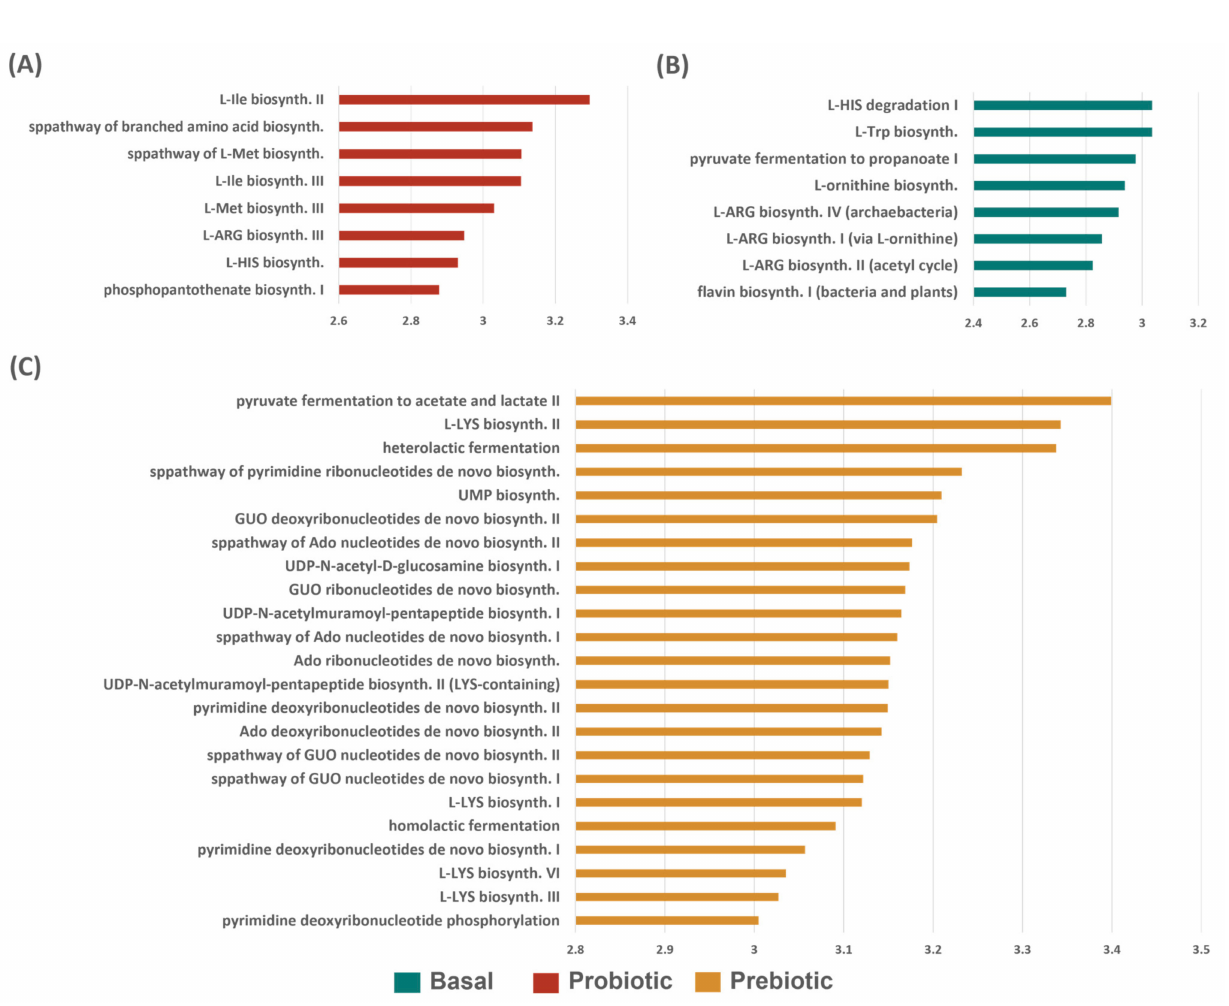
Figure 6. Selected results of differential functional pathway abundance testing from Linear Discrimi- nant Analysis (LDA) Effect Size (LEfSe) grouped by dietary treatment: ( A ) Probiotic, ( B ) Basal, and ( C ) Prebiotic. Functional output pathways of the bacterial microbiota were predicted via PICRUSt2. Pathways shown were found to have significantly higher relative abundance in the specified group relative to all other groups with an LDA Score (log 10) > 2.5 and p <